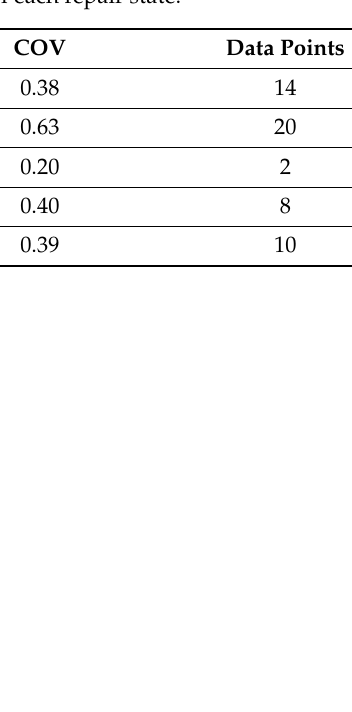
Figure 2. Distribution diagram of repair state data and inter-story